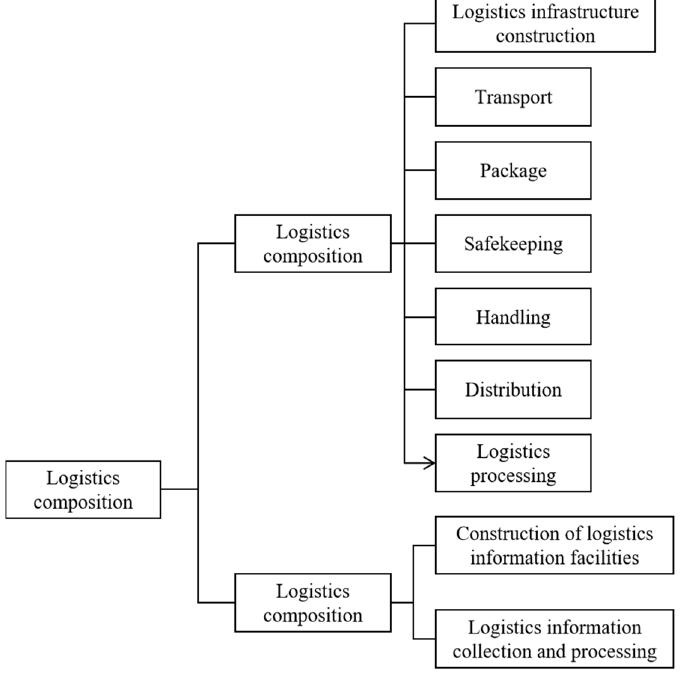
Figure 2. The basic elements of logistics.